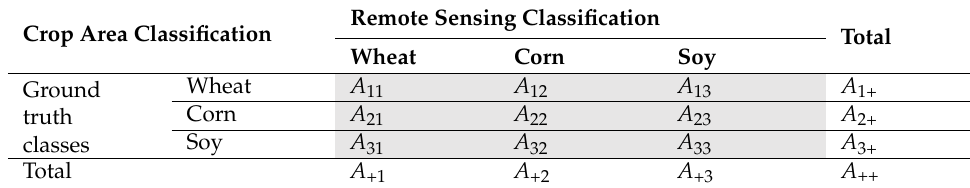
Table 1. Example of a Q matrix in table form. Crop Area